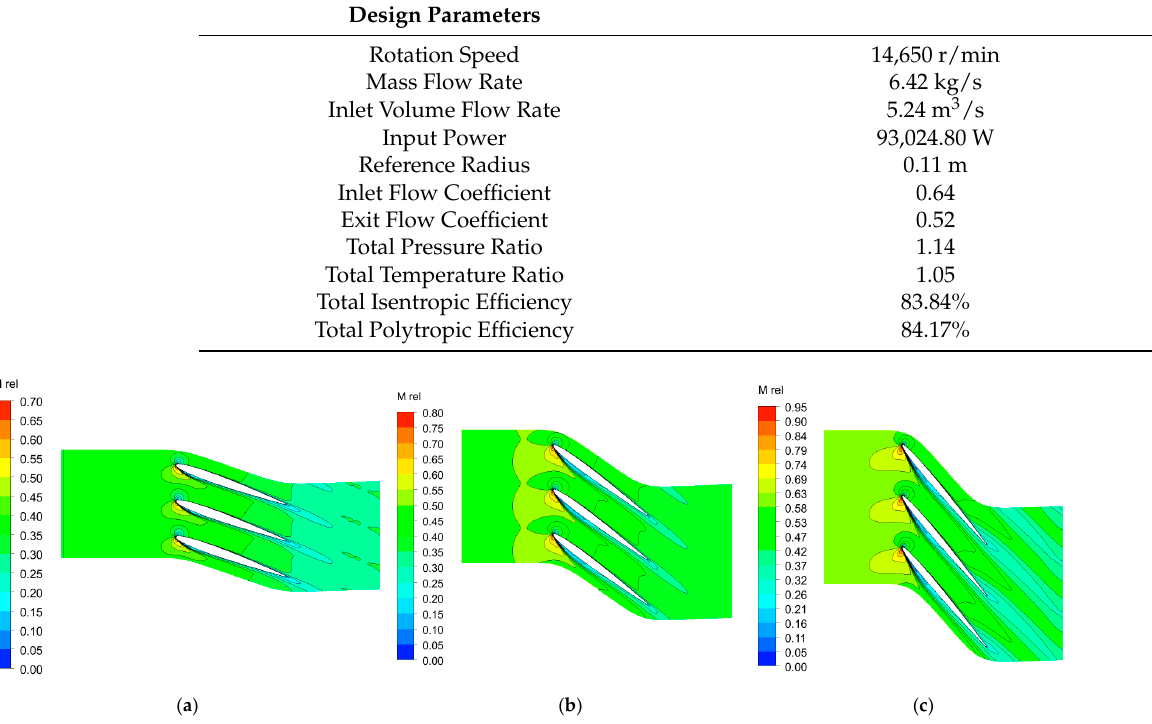
Table 3. Performance of the initial model.